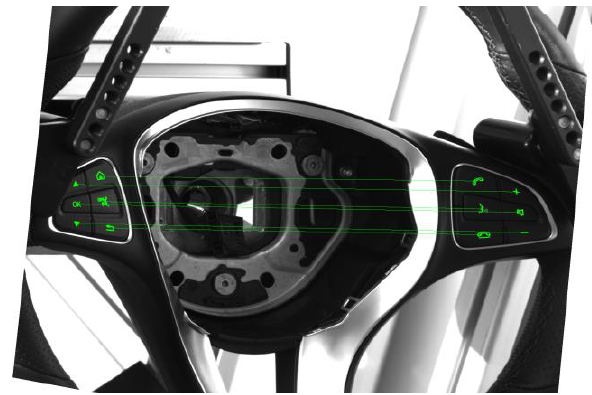
Figure 13. Point-to-point matching using several pairs of points to compute the slope in the rectified